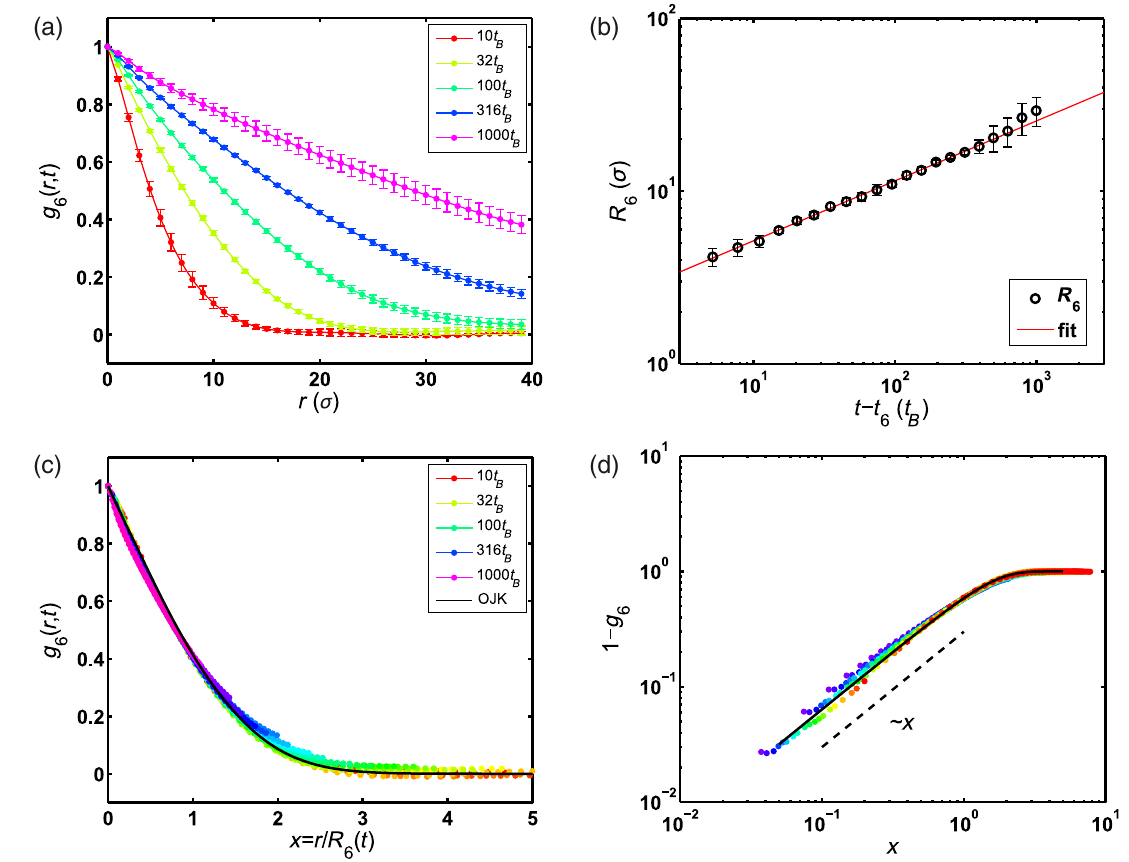
FIG. 2. (a) The bond-orientational correlation function g 6 ð r; t Þ as defined by Eq. (B3) for different times. (b) Time-evolution of the bond-orientational correlation length R 6 . The red solid line is the result of the fit to R 6 ∼ ð t − t 6 Þ α 6 . All error bars correspond to the standard deviation of the different experimental runs. (c) The correlation function g 6 as a function of the distance rescaled by the correlation length R 6 . The solid black line is the correlation function given by OJK theory; see Eq. (8). (d) A log-log plot of 1 − g 6 as a function of the rescaled distance x ¼ r=R 6 ð t Þ , which scales as x (black dashed line) following the prediction from Porod ’ s law; see Eq.